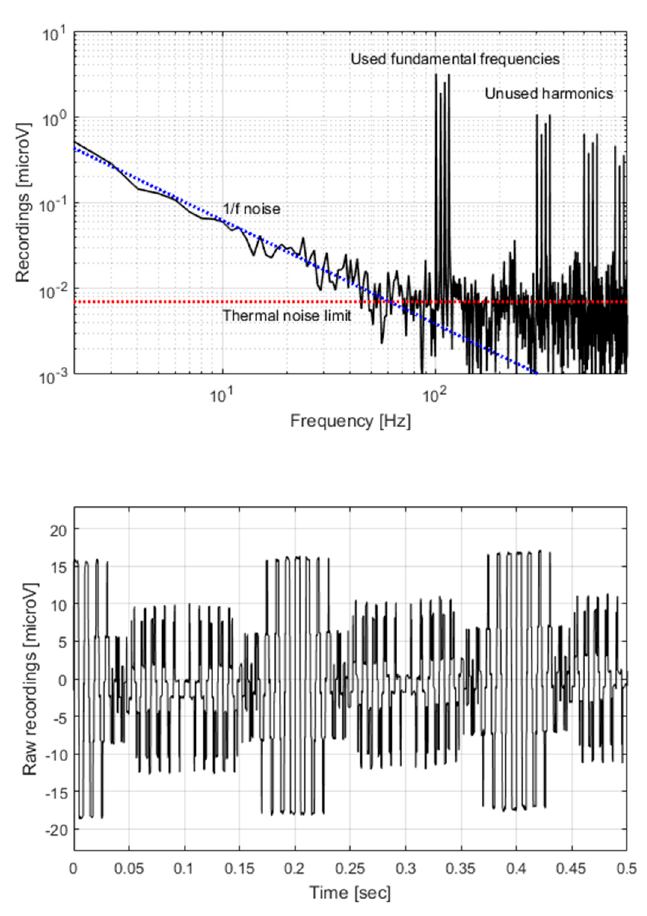
Figure 5. Four piezoresistive (thus four frequencies) setup with FFT plot ( top ) and time domain signal ( bottom ). Binary modulation frequencies was 200 Hz, 210 Hz, 220 Hz and 230 Hz. Signal levels are 3– 5 µV, noise floor is near 8 nV/√Hz for the sensing element of 3.6 kΩ , the measurement time was 1 s. The applied modulation voltage is ±0.6 V, the applicable force SNR of the sensor, constraint mechanically by sensor damage, is near 100 dB with the